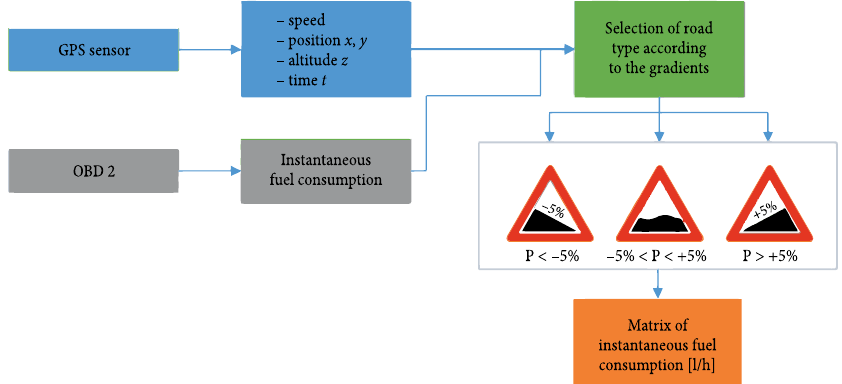
Fig. 1. Methodology for defining the matrix of fuel